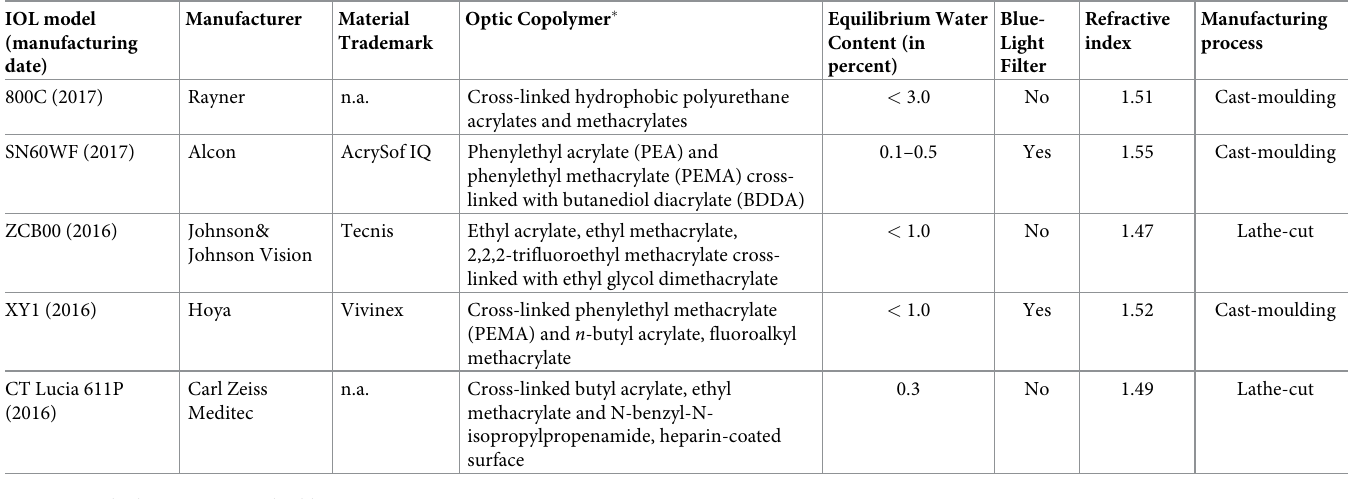
IOL intraocular lens; n.a. not applicable; � Information on Optic Copolymer was provided by the